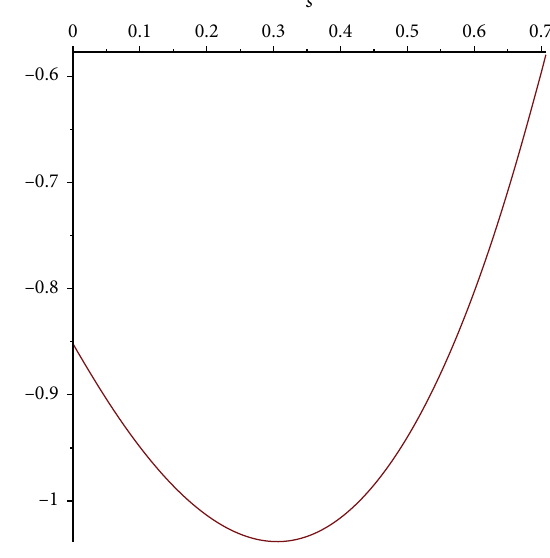
ffiffiffi p (cid:2) 2